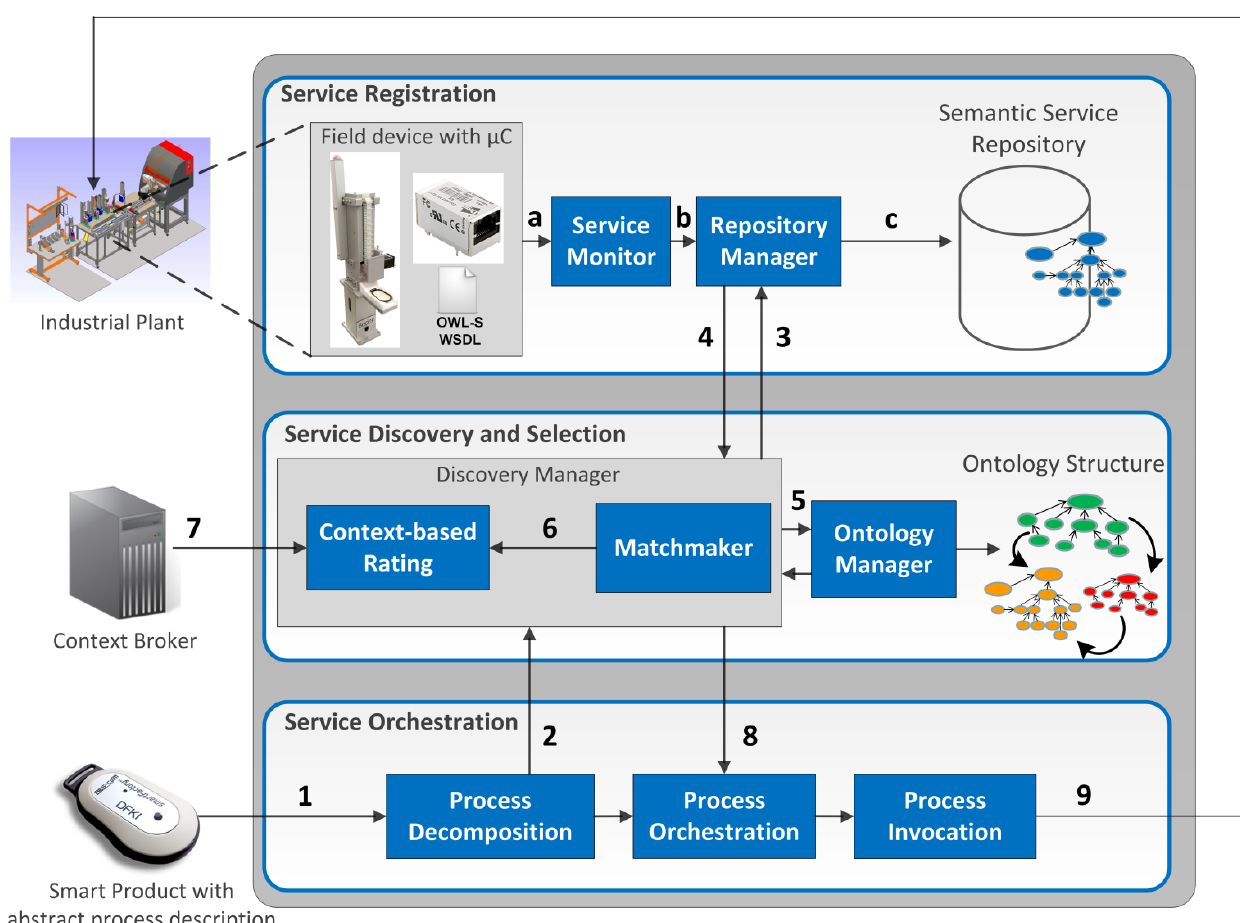
Figure 5. Orchestration system